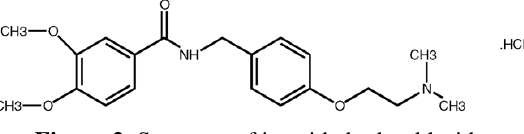
Figure 2. Structure of itopride